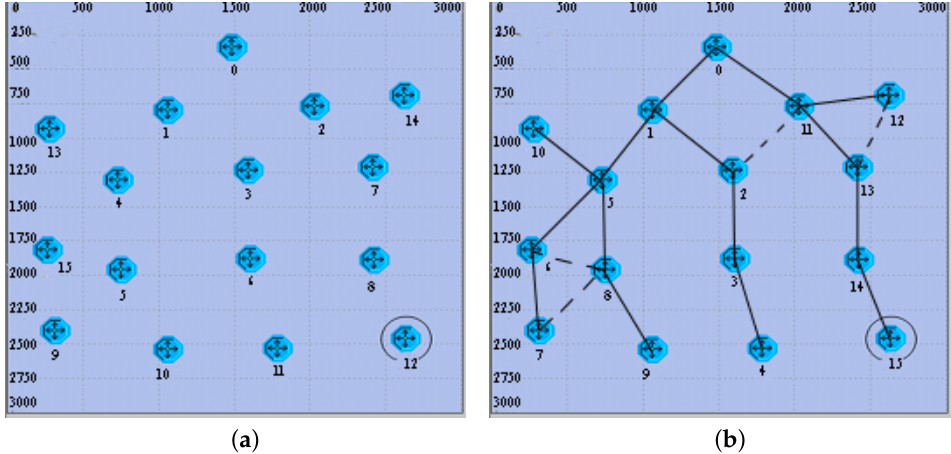
Figure 4. The network connectivity achieved after ETDP procedure. ( a ) A random network with no structure; ( b ) Topology acquired after the ETDP is